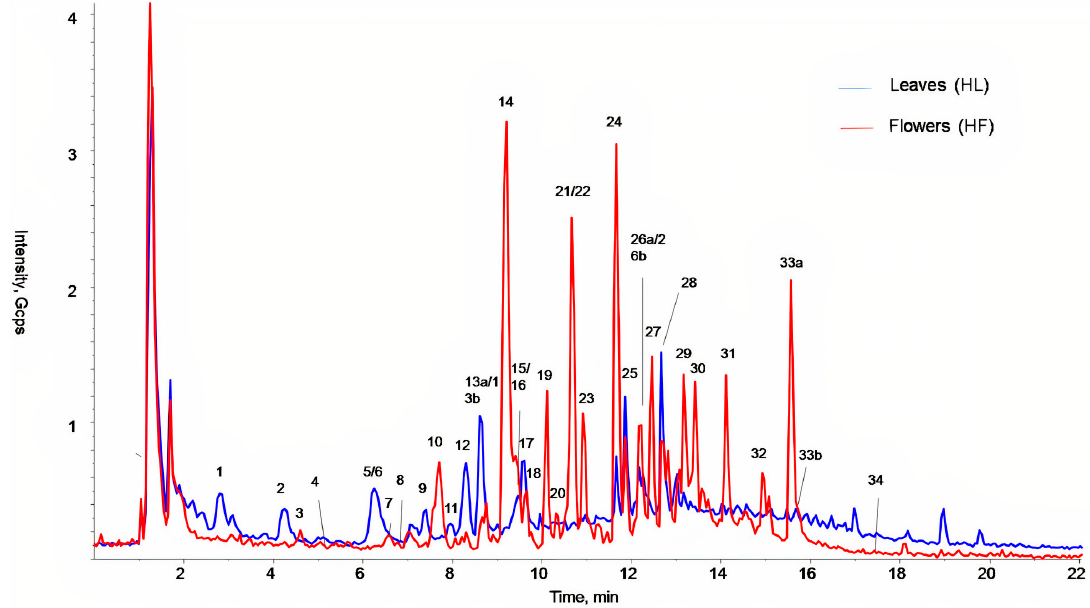
Figure 1. HPLC-MS (Scan 100–1000 Da, negative ions) chromatogram of Hibiscus roseus ethanolic extract of leaves (blue line) and flowers (red line). Table 1. Putative identification of the main phenolic compounds found in leaf (HL) and flowers (HF) extracts of Hibiscus roseus by LC-MS/MS-MRM. Compounds numbers correspond to those indicated in Figure 1.